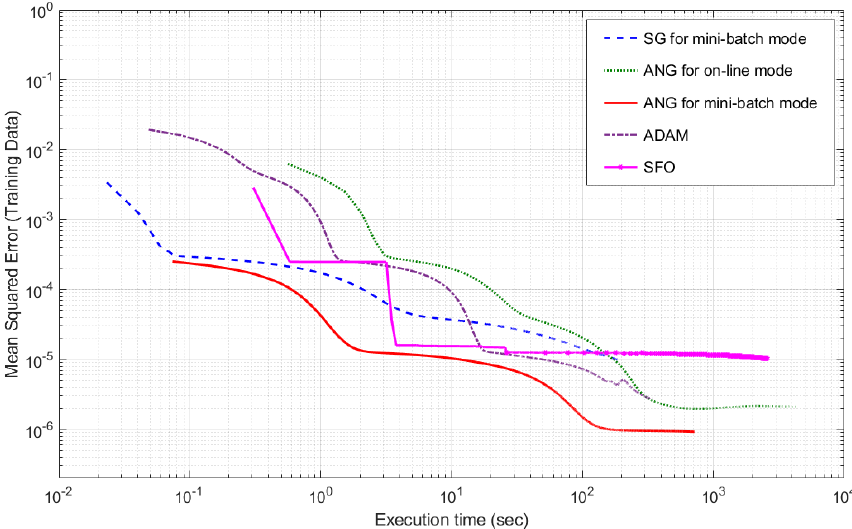
Figure 3. Change of prediction errors for Mackey-Glass series depending on the execution time.